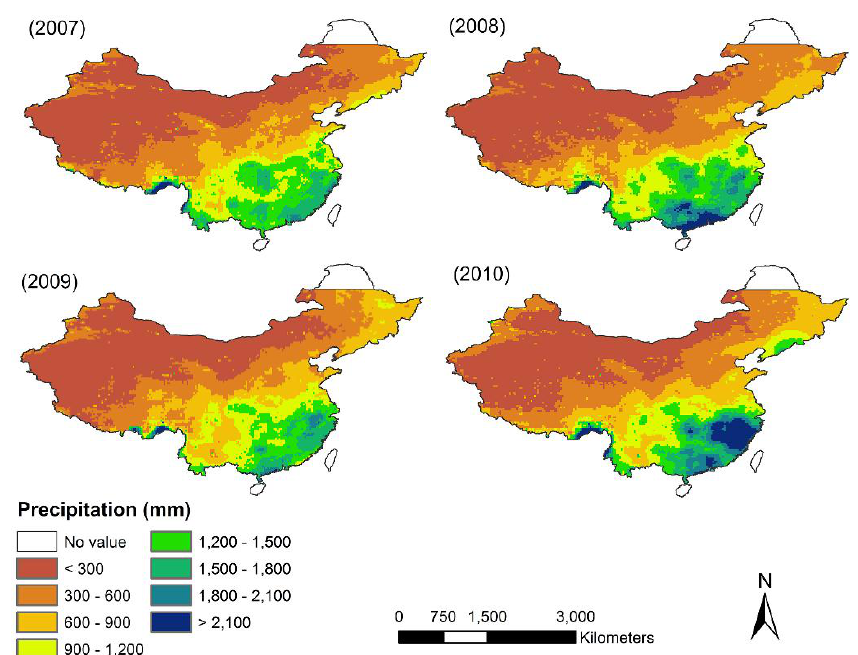
Figure A1. Annual precipitation of China mainland at spatial resolution 0.25° × 0.25°for the period years from 2001 to 2010, aggregated from the original monthly TRMM 3B43 V7 precipitation product.